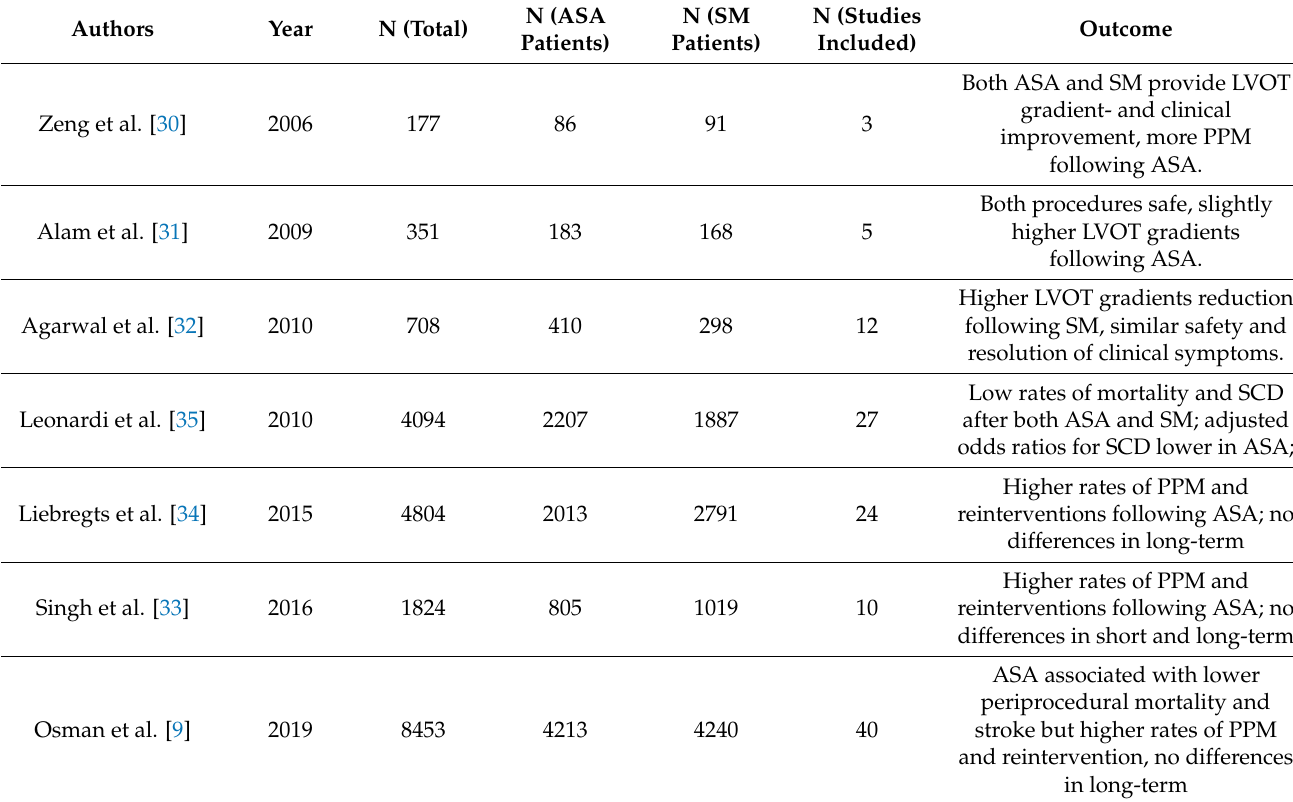
Table 3. Meta-Analyses comparing septal reduction therapies (ASA and